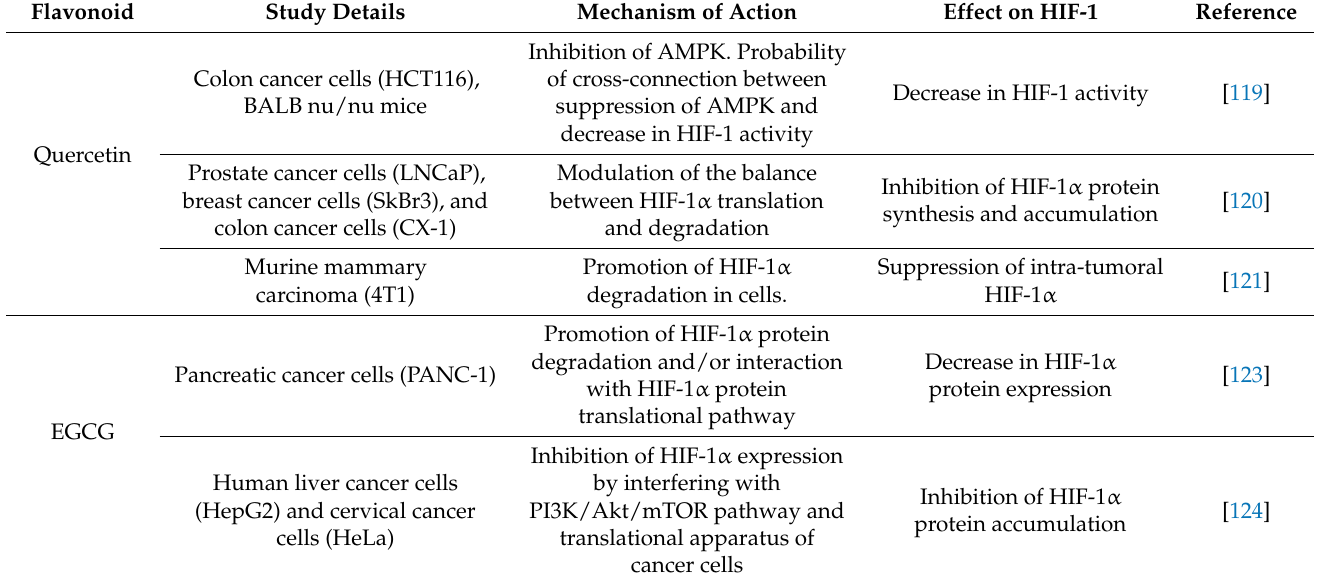
Table 2. Role of flavonoids in the modulation of